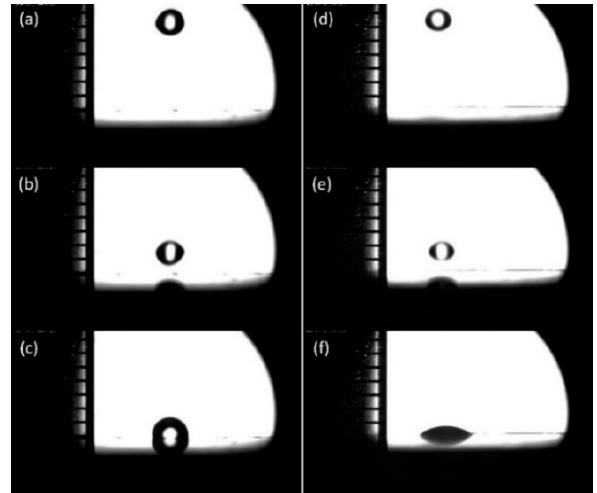
Figure 5. Partial screenshots of droplets falling from 1 cm altitude: water droplet ( a , b , c ) and organosilicon adjuvant droplet ( d , e , f ).